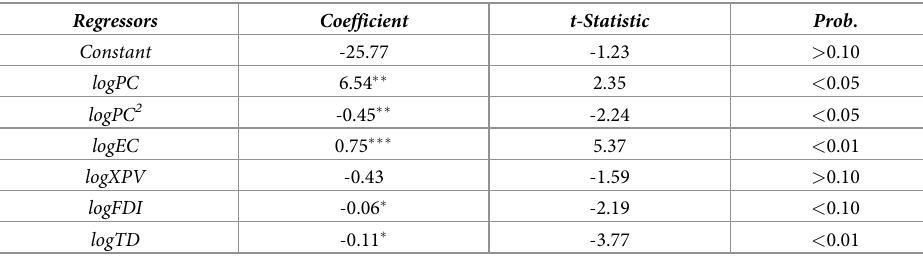
��� , �� and � indicate significance at the 1%, 5% and 10% levels, respectively.